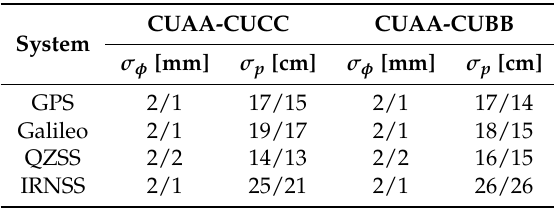
Table 1. L5 multipath-uncorrected phase ( σ φ ) and code standard deviations ( σ p ) for GPS, Galileo, QZSS and IRNSS satellites. The standard deviations are given for elevation masks of 10/40 degrees. The data on DOY 223 was used for computing the standard deviations for GPS, Galileo and IRNSS, and the data on DOY 153, 2018 was used for computing the QZSS standard